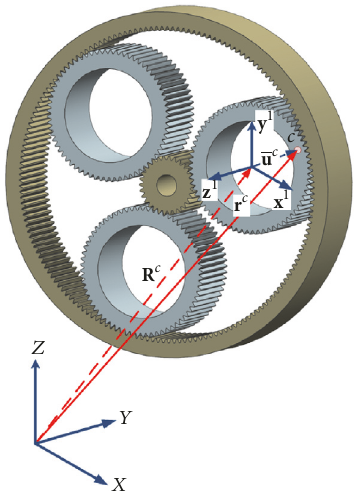
Figure 2: Multibody model of epicyclic gear train, showing only one body frame and displacement field of point 𝑐 ; the holonomic constraints include the rigid joint between the ring gear and ground and revolute joints between gears and ground. The nonholonomic constraints include the zero relative velocity between meshing gears at contact